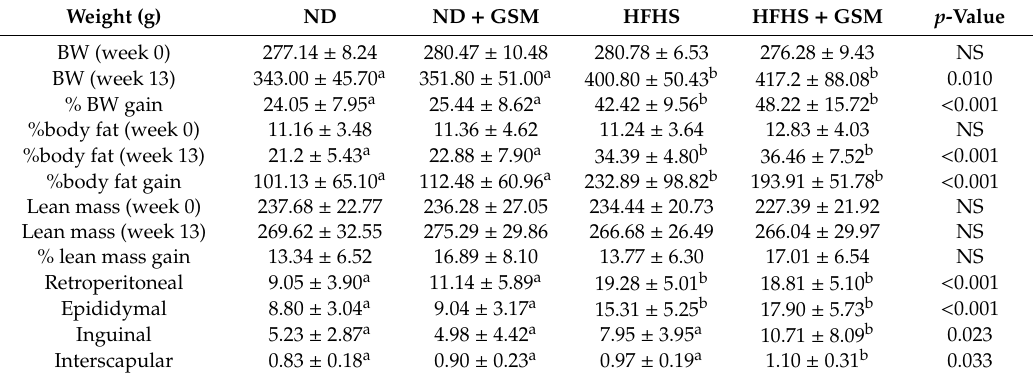
Table 2. Body weight and fat deposition of the rats at the end of the study.